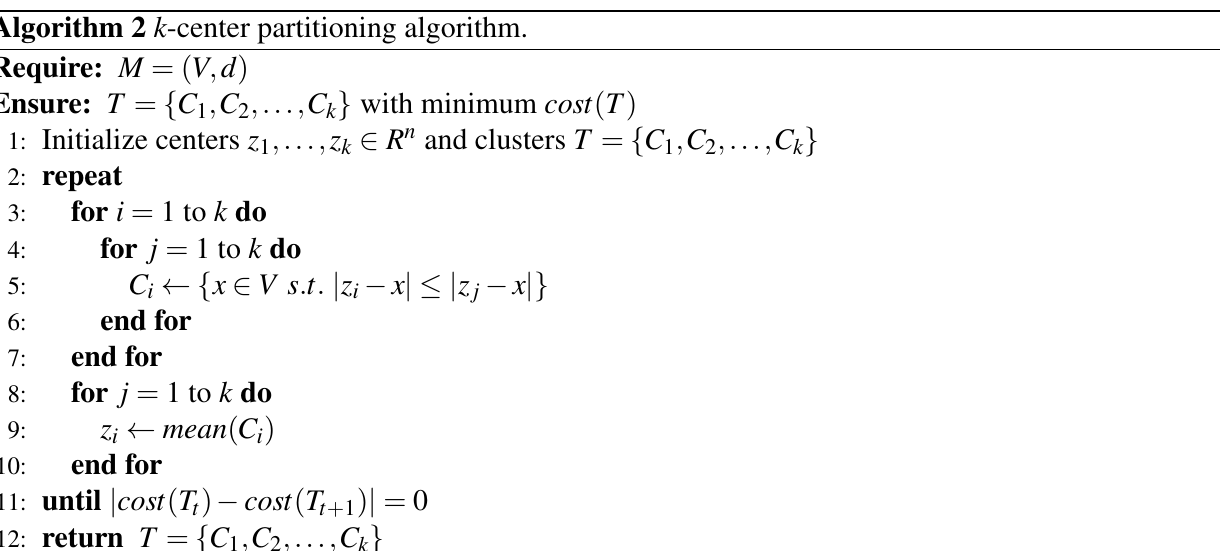
Algorithm 2 k -center partitioning